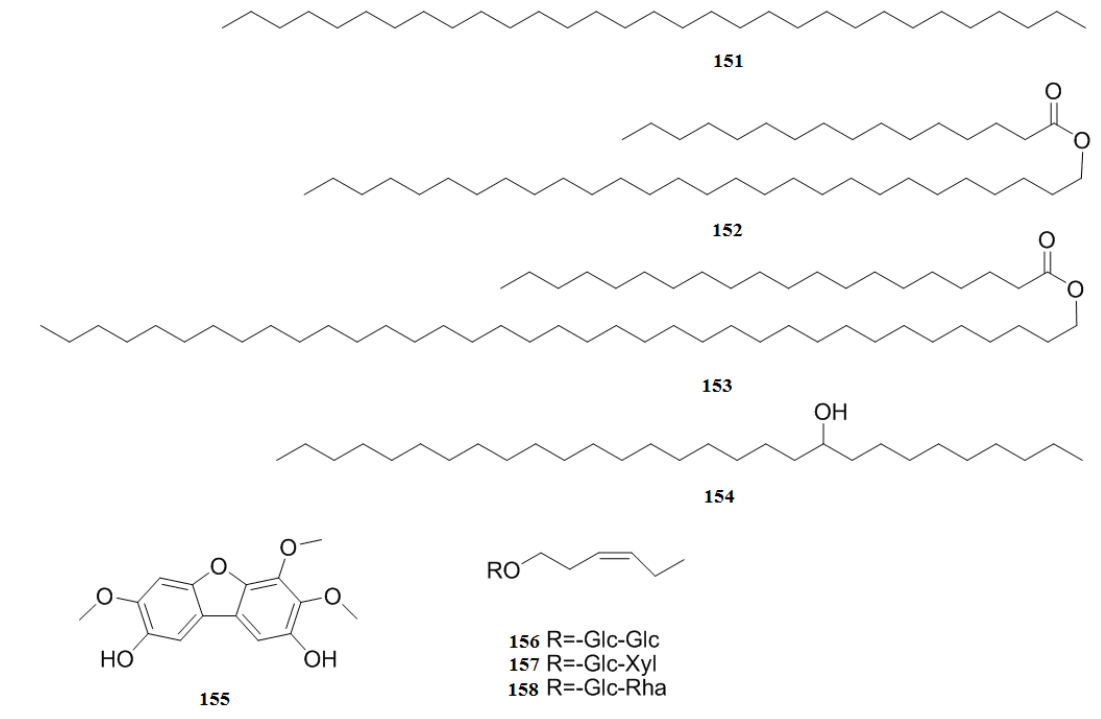
Figure 12. Chemical structures of other compounds in C. pinnatifida